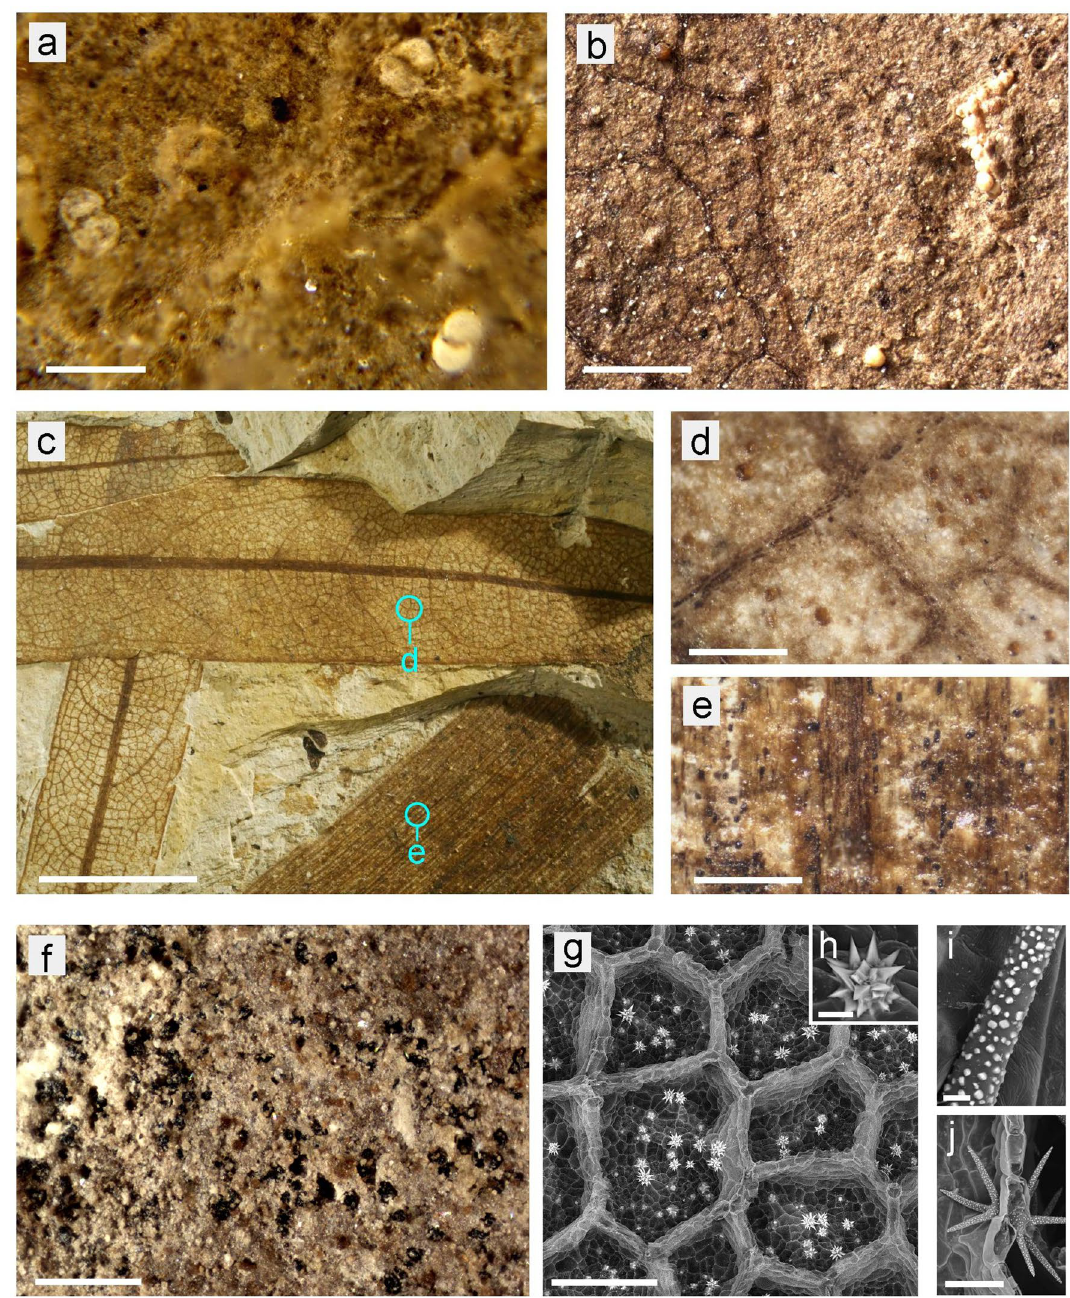
Figure 7. Topics for Discussion: ( a – e ) Differentiation between traces of druses and pollen. LM image of Sample Ro-58.5 (‘ Zizyphus zizyphoides ’) with pollen-like structures randomly distributed. Their shape resemble conifer pollen. (b) Sample Ro-4.4 (‘ Acer integrilobum ’); the globules of ca. 100 µm diameter, distributed on (left side) and beside (right side) leaf area may be pollen. ( c – e ) Sample Ro-2.2 (‘ Sideroxylon ’) with different leaves. The larger ones contain globules of different size ( d ), the other one small black particles ( e ), no globules were found in the mineral sediment. Such patterns cannot originate from pollen. ( f – j ) Uncertainty in the identification of leaf fossils. ( f ) LM image of sample Ro-13.3, which has been assigned to ‘ Nymphaea nymphaeoides ’, shows black granules. ( g – h ) SEM images of a fresh leaf of Nelumbo nucifera (Lotus) show CaOx druses in similar distribution and size as sample Ro-13.3; inset ( h ) shows a single druse in detail. ( i , j ) SEM images of mesophyll cells in a fresh leaf of Nymphaea lotus , carrying only small CaOx crystals (< 5 µm) ( i ) on the surface of sclereid cells ( j ). Scale bars: ( a ) = 100 µm; ( b ) = 500 µm; ( c ) = 5 mm; ( d , e , f , g ) = 200 µm; ( h , i ) = 10 µm; ( j ) = 100